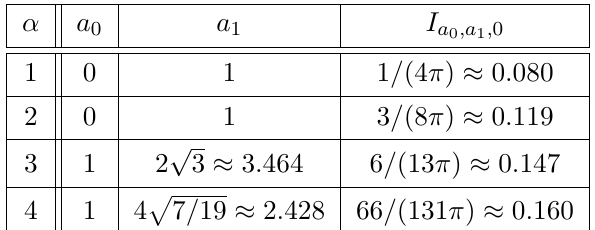
Table 2. The values of the parameters that minimize I a the values of I a are greater than the values obtained in the case when a 2 6 = 0 . When α grows, 0 ,a 1 , 0 one vortex has to appear far from the